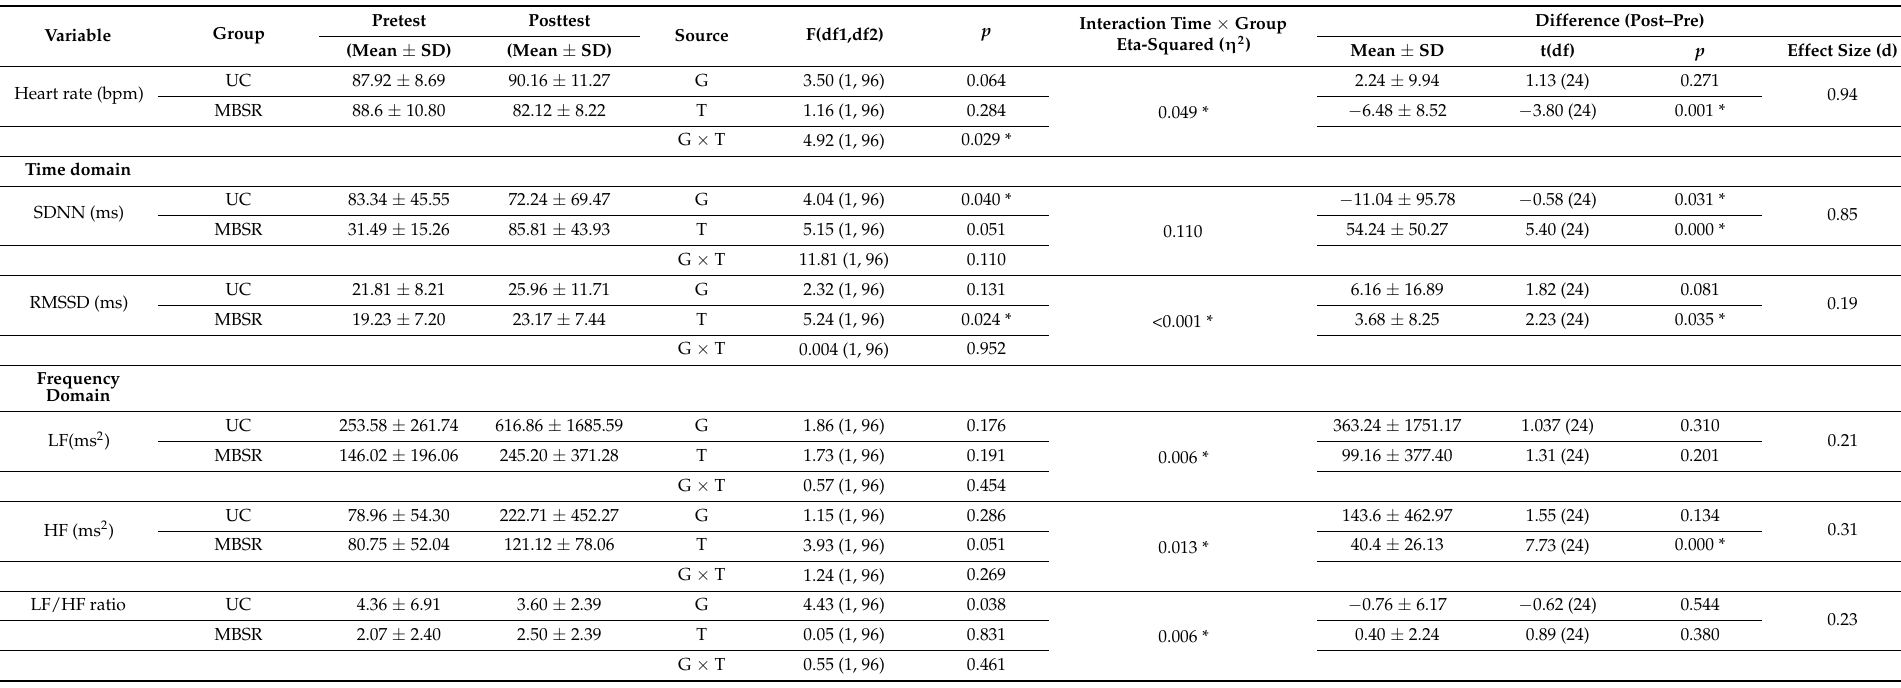
Table 3. Comparisons of HRV parameters between groups over